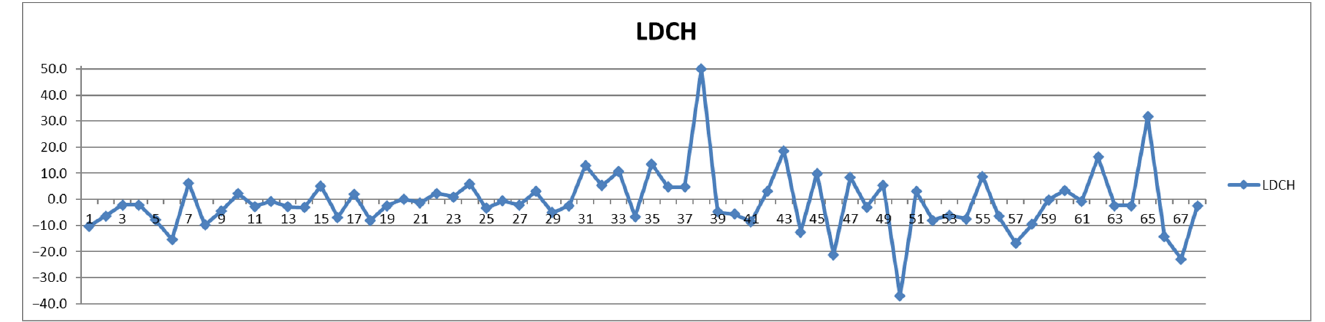
Figure 10. The food intake effect on LDL cholesterol (LDCH) as difference between postprandial and fasting concentrations as percentage relative to fasting concentration.